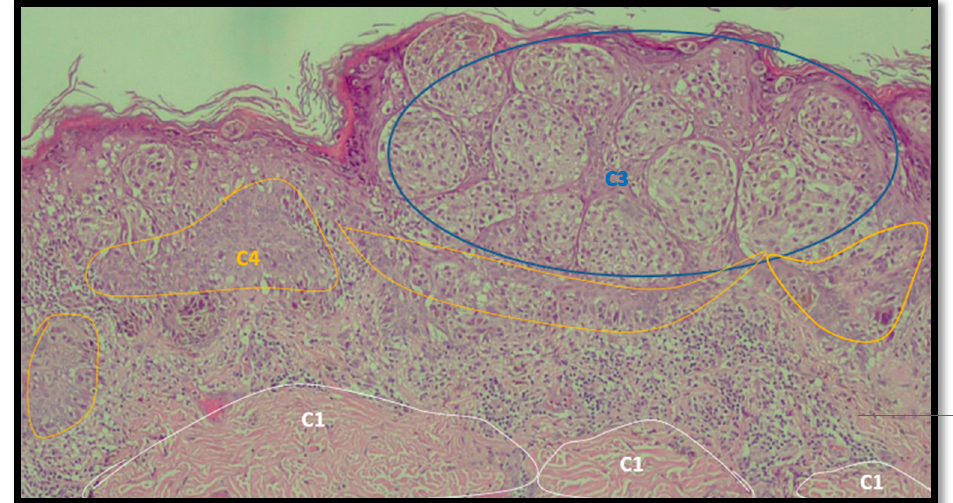
Figure 3. Example of analysis and selection of defects (such as architectural and cytological atypia, pagetoid spreading, possible ulceration) in the macro-area of an image of malignant melanoma. Note the different colors of the circles/ellipses used to subclassify the anomalies (defects). In Tables 2 and 3 the FRF enhancement of possible classified defects are shown by estimating the percentage coverage in 1 mm × 2 mm images.